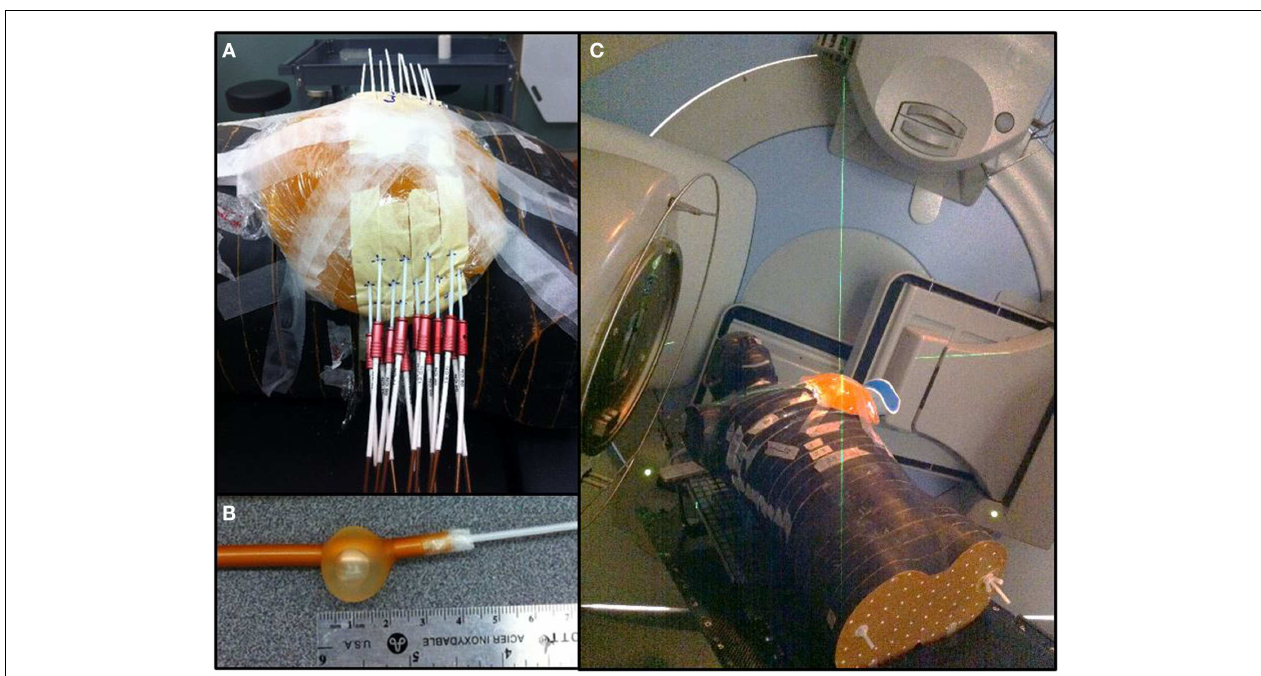
FIGURE 3 | Breast treatments . (A) Multicatheter HDR APBI. (B) Foley catheter used for balloon HDR APBI. (C) 3D-CRT APBI.